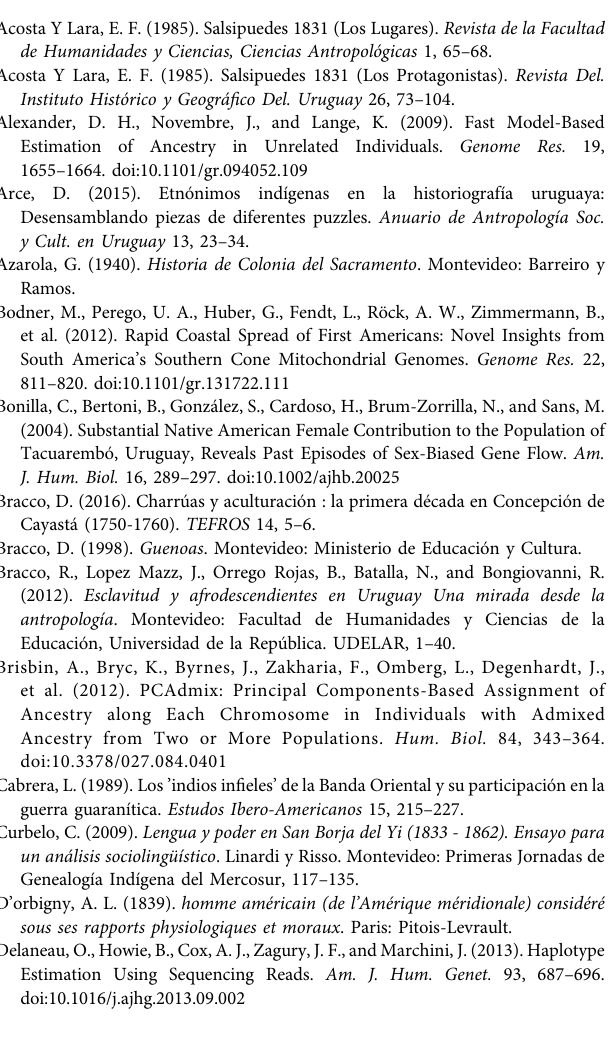
Figueiro, G., Cabrera Pérez, L., Lindo, J., Mallott, E. K., Owings, A., Malhi, R. S., etal. (2016). Análisis Del Genoma Mitocondrial De Dos Individuos Inhumados En El Sitio Arqueológico Cg14E01 "Isla Larga" (Rocha, Uruguay). Rev. Arg Antrop Biol. 19, 17.